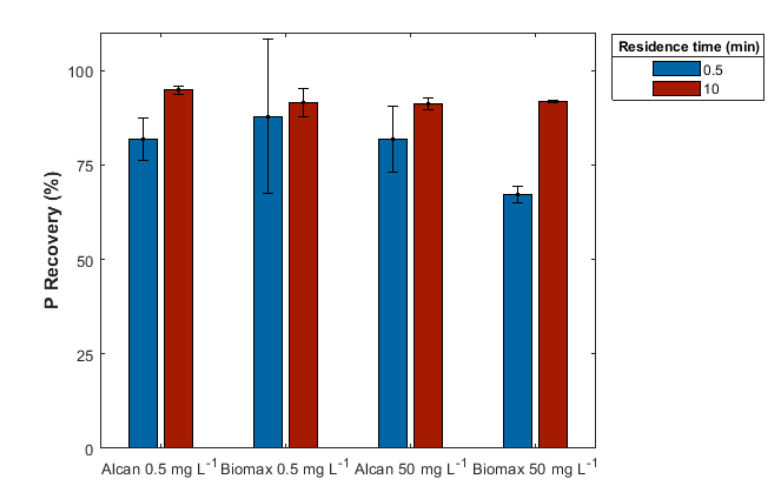
Figure 5. Effects of regeneration residence time on phosphorus (P) recovery from P sorption materials (PSM). Phosphorus recovery is shown after the first sorption cycle (S0-D0) only, treated with 20 pore volumes of 1 M KOH and no recirculation. Treatments separated based on PSM type and P concentration used during the sorption